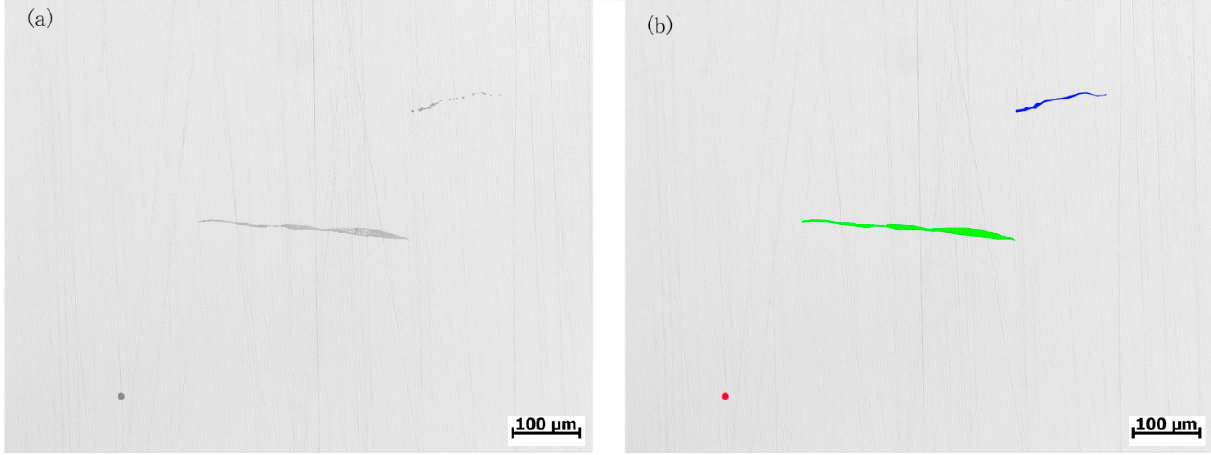
Figure 1. Original metallograph ( a ) and its labeling result ( b